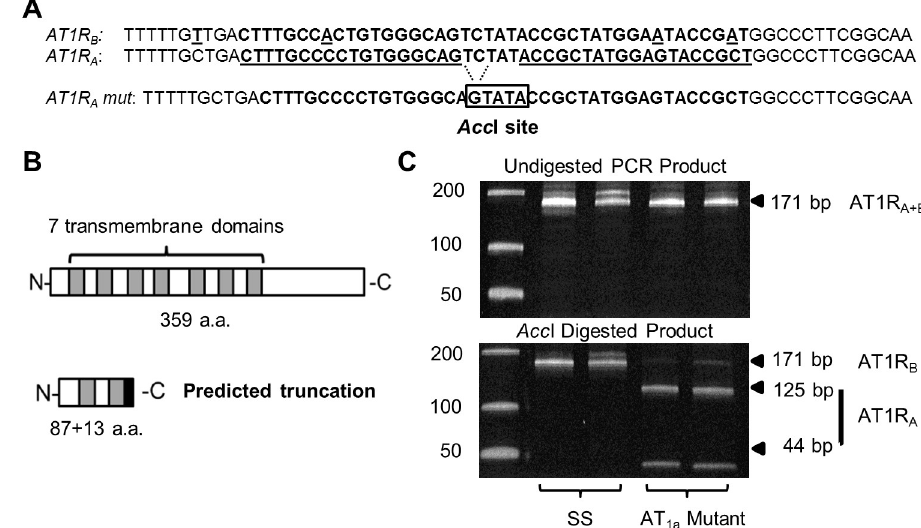
Fig 1. Validation of the AT1R A -specific knockout. (A) ZFNs specifically targeting the AT1R A ( Agtr1a ) gene were designed in a region of exon 3 where specific sequence differences (underlined) would prevent ZFN binding and mutagenesis of AT1R B ( Agtr1b ). The ZFN target is in bold and the specific monomer binding sites are underlined. A frame-shifting 2-bp deletion results in the formation of an Acc I restriction endonuclease site specifically in the AT1R A mutant (boxed). (B) The frameshift results in an predicted early truncation of the nascent AT1R A peptide containing 87 normal amino acids and harboring only the first two of seven transmembrane domains, followed by 13 nonsense amino acids. (C) PCR on cDNA reveals the expected amplification of AT1R A and AT1R B mRNAs with an expected product of 171-bp (expected 169-bp for the AT1R A mutant). Acc I restriction endonuclease specific cleavage of the 169-bp mutant AT1R A transcript into two fragments of 125 and 44-bp in AT1R A mutant rats (SS-AT1KO), but not control SS animals (SS-AT1WT).